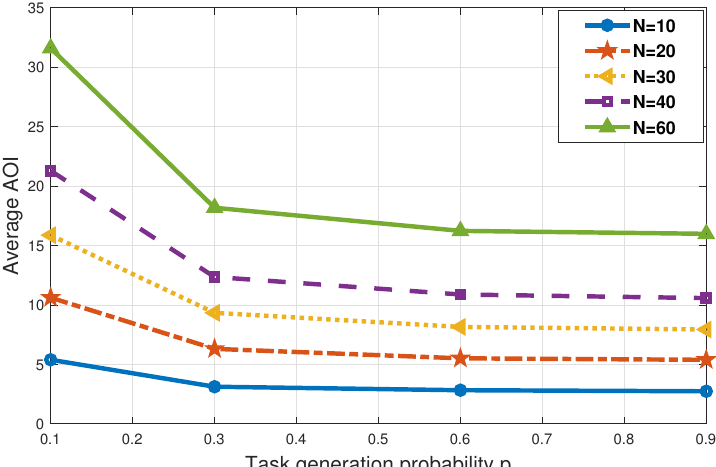
Figure 7. In the case of v = 2 m/s H = 15 m, the impact of different task generation probability p on average AoI.